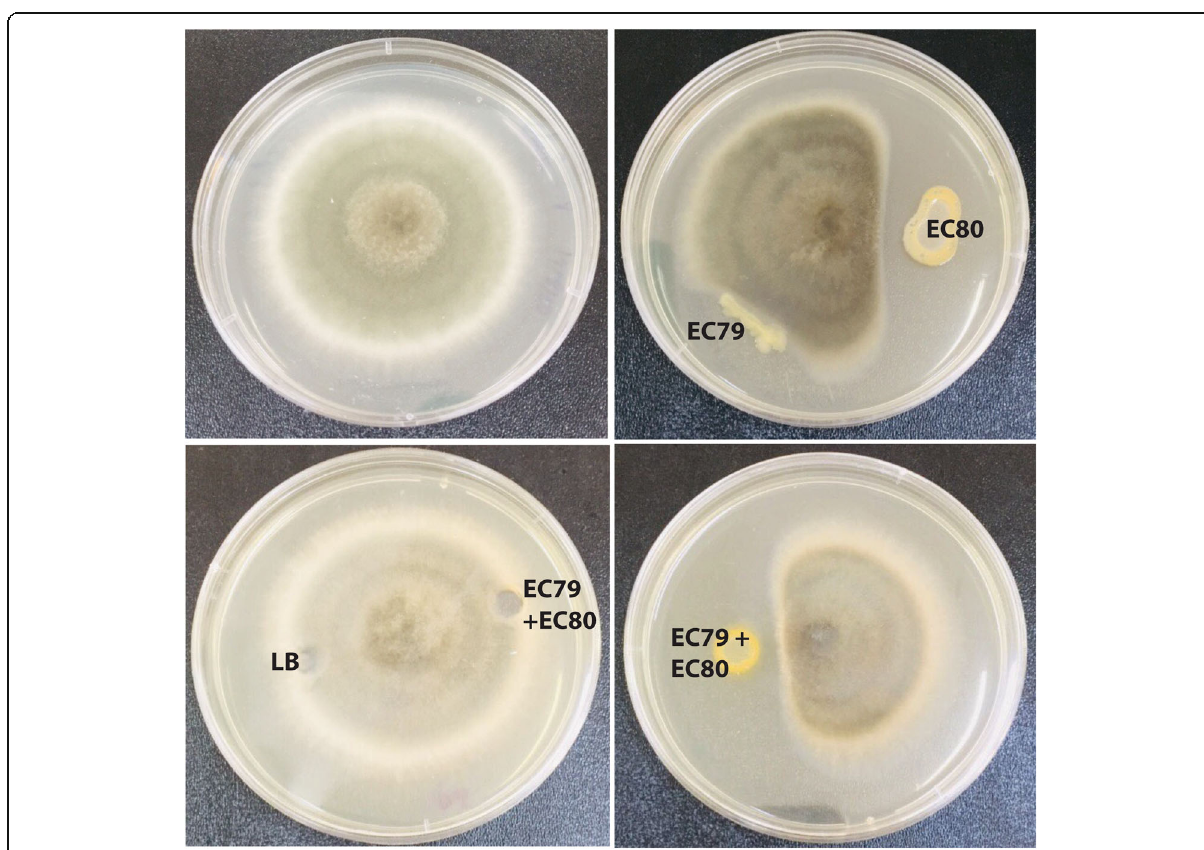
Fig. 2 Co-culturing of two endophytic bacterial strains on fungal growth of Alternaria alternata . Up-left panel: A. alternata on PDA media; up-right panel: antagonistic assay of EC79 and EC80 on A. alternata on PDA media; down-left panel: antagonistic assay of combined EC79 and EC80 on A. alternata on PDA media; down-right panel: antagonistic assay of filtrates of EC79 and EC80 on A. alternata on PDA media